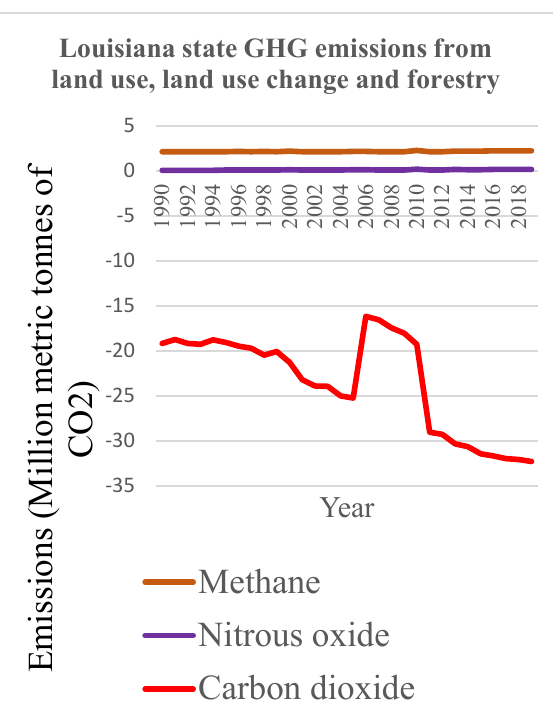
Fig 2: NDVI map of the study area (2010) (A)